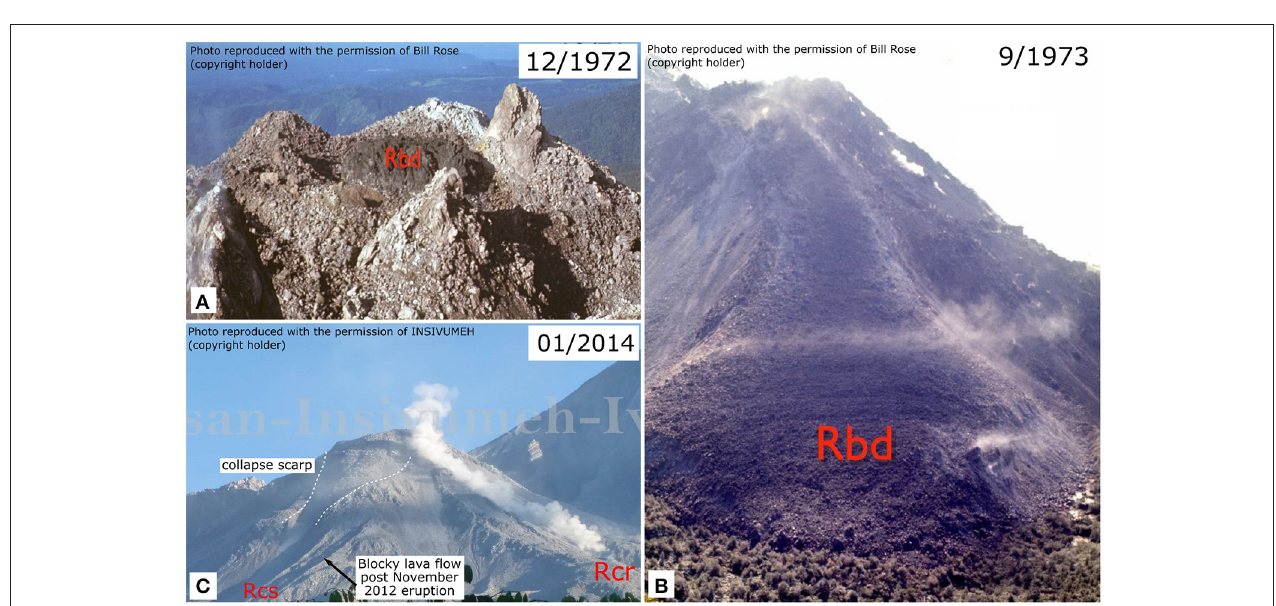
FIGURE 11 | Evolution of vesicular lava into blocky lava. (A) Vesicular lava extruding on El Brujo, surrounded by older spines. (B) Photo of the same flow front, 10 months later, with increased brecciation of the flow top. (C) Proximal lava infills a collapse scarp; the lava flow top is made up of large blocks in comparison to longer flows (as in B ). See also the blocky lava flow (Rcs) that advanced in the months after the November 2012 collapse, following the initial vesicular lava flow. Note the small block and ash flow descending the dome.